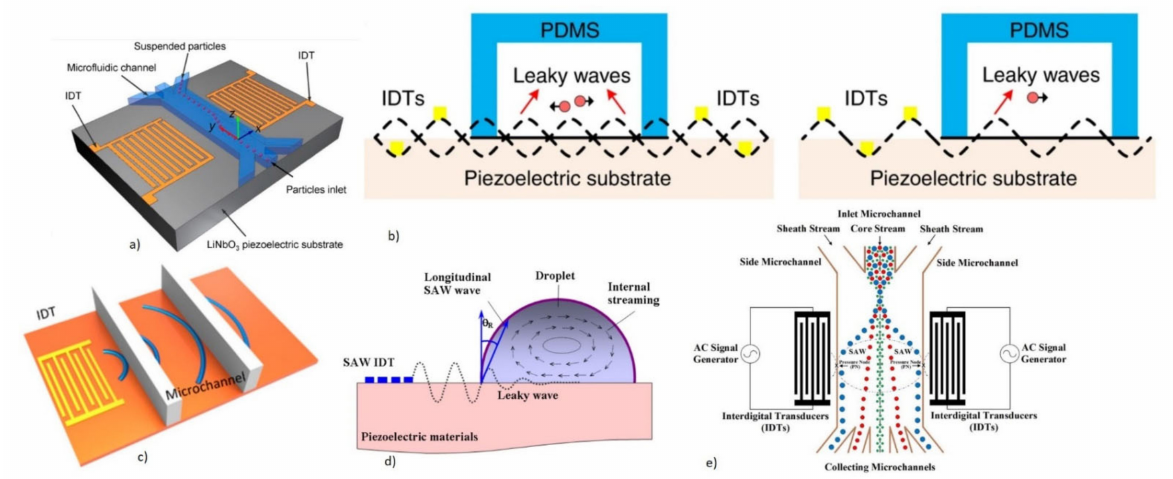
Figure 38. ( a ) Schematic of TSAW microfluidic device with a single IDT [321]. Reproduced with permission from Y. Gao et al., Micromachines; published by MDPI, 2020 (open access). ( b )